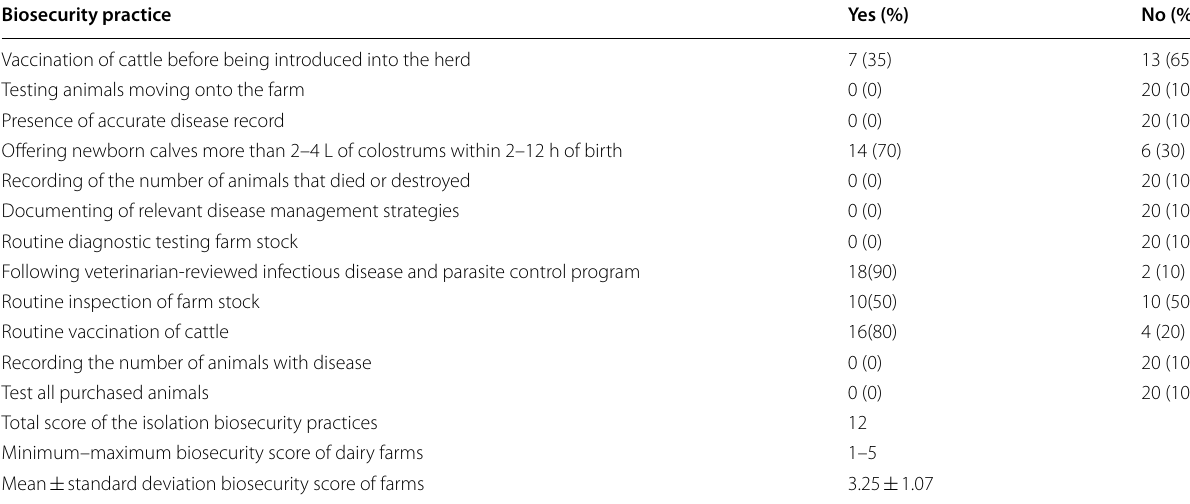
Table 7 Percentage practices of the animal health management biosecurity components Biosecurity practice